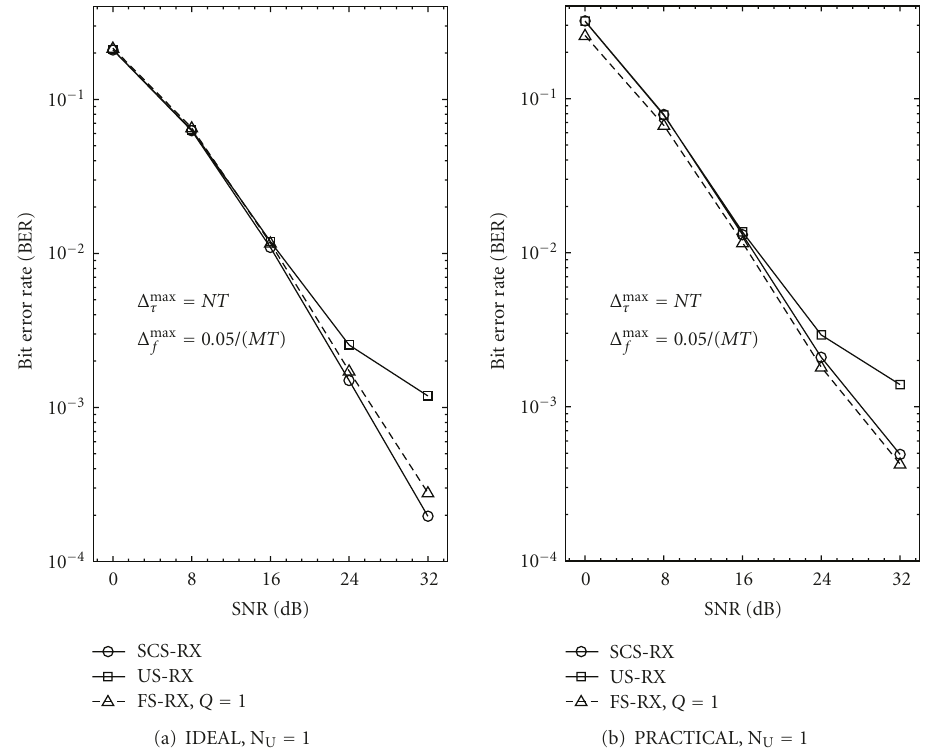
Figure 6: verage BER as a function of the SNR. Ideal and practical performance with 1 user. The training sequence length is equal to 30